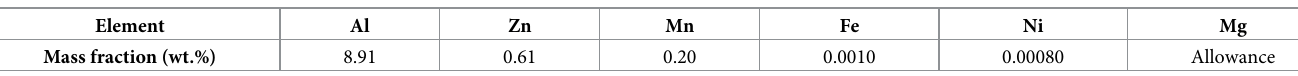
Table 1. Composition of AZ91